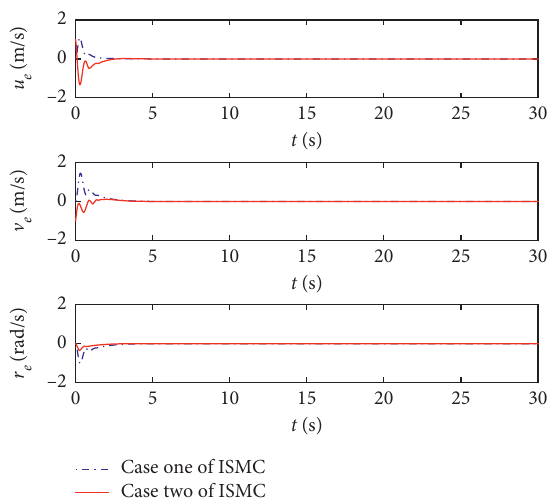
Figure 5: Velocity tracking errors on ISMC with different conditions.